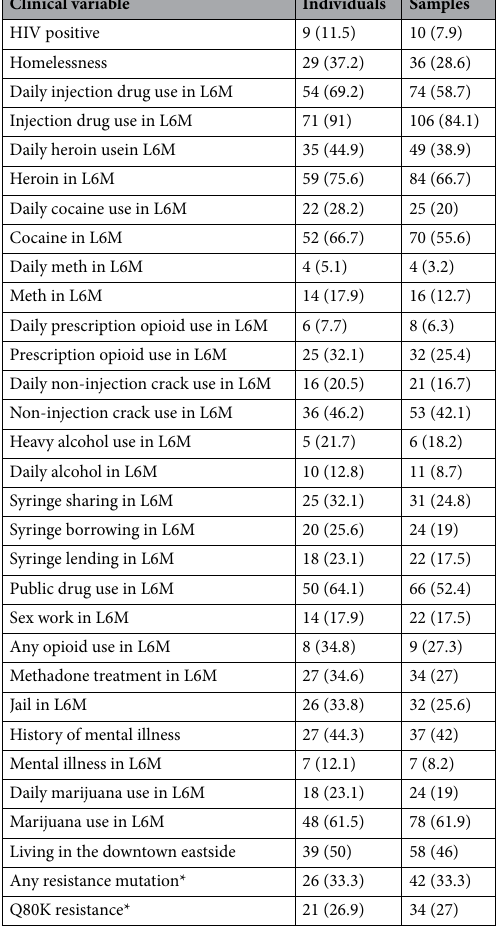
Table 1. Behavioural variables measured in this study for 78 participants. Counts for all behavioural variables available for analysis in this study for each individual/sample as well as the percent positive (in parentheses). *Measured from deep sequencing analyses. L6M represents last 6 months prior to sample collection. Positives for each variable are defined as positive at any point during